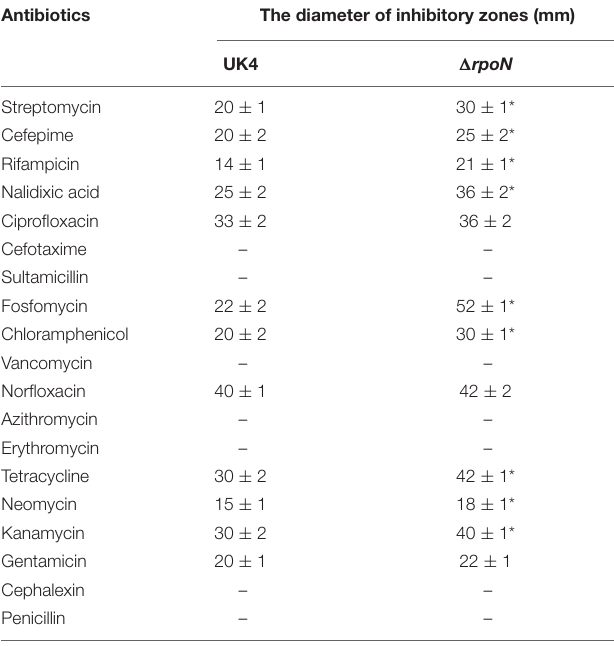
TABLE 1 | Results of antibiotic susceptibility of the wild-type and the rpoN mutant strains. Antibiotics The diameter of inhibitory zones (mm)